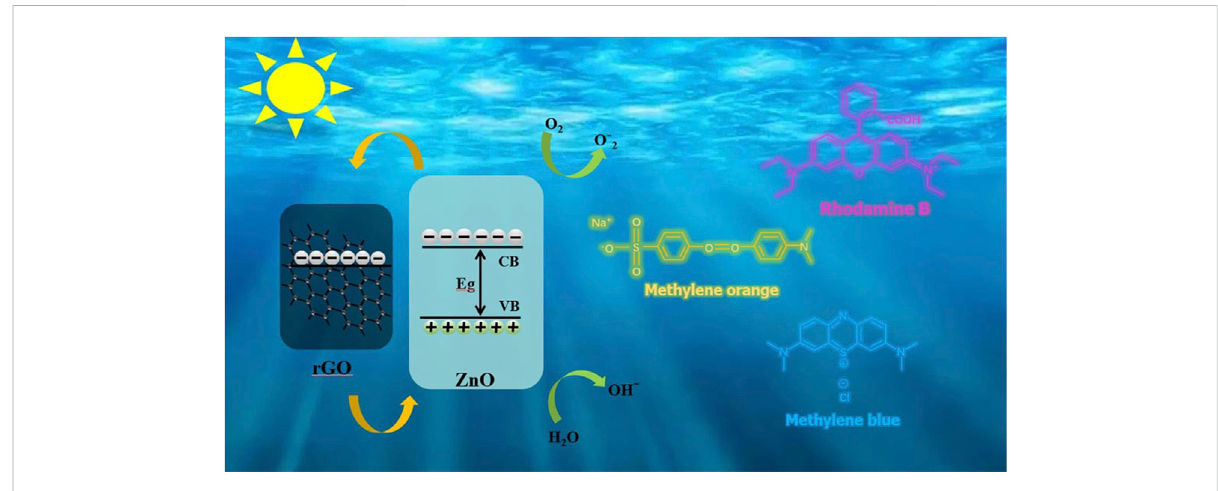
FIGURE 14 Diagram of the photocatalytic degradation mechanism of ZnO-rGO